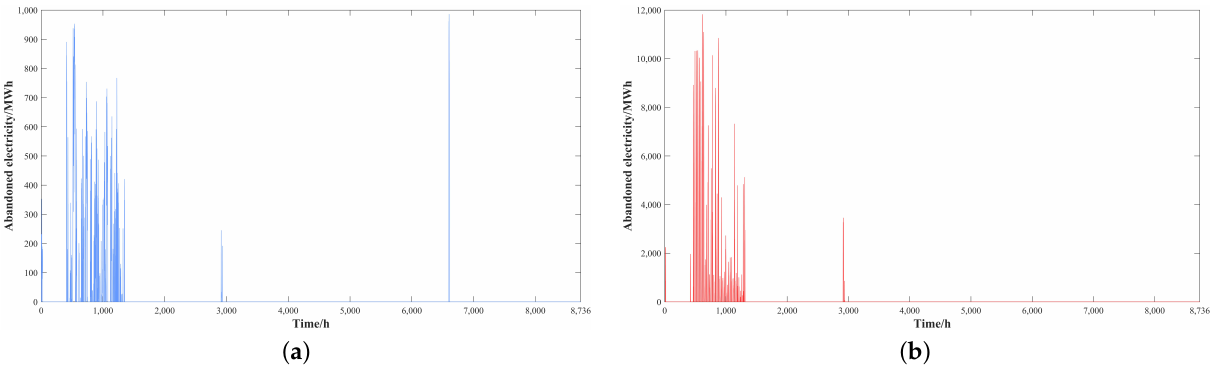
Figure 12. Full-time curtailment curve of renewable energy in Case B. ( a ) The curve of wind-power curtailment. ( b ) The curve of PV power